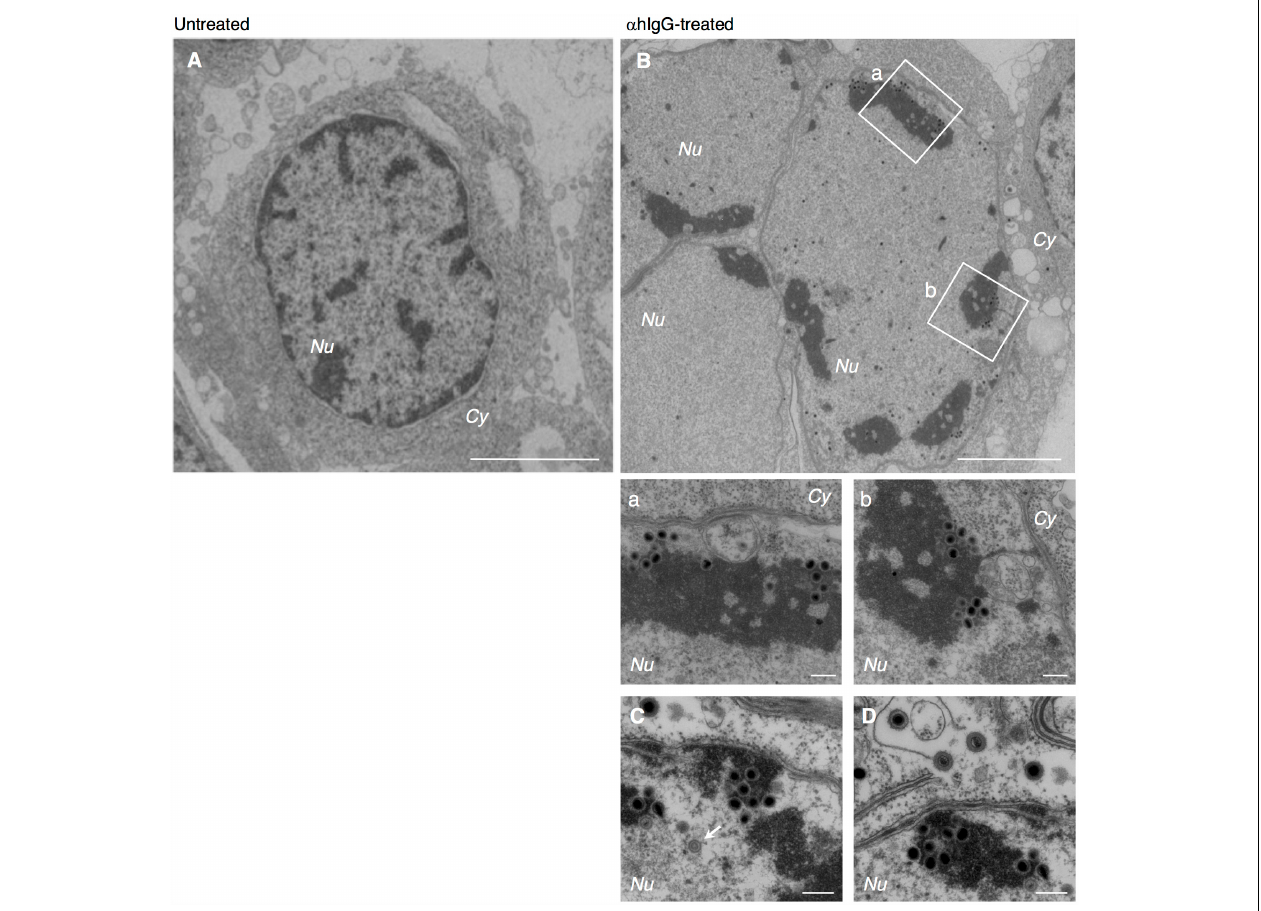
FIGURE 1 | Electron micrograph showing nucleocapsid formation in the nucleus of Akata cells induced into the lytic cycle of EBV. Morphological features of Burkitt’s lymphoma cells induced lytic infection of EBV. Akata − eGFP-EBV cells were treated without (A) or with (B) α hIgG for 24 h. Low (A,B) and high (a,b,C,D) power views of Akata − eGFP-EBV cells. (a) and (b) represent boxed areas in (B) . The white arrow indicates a double-layered capsid without core. Scale bars: 2.5 µ m (A,B) and 250 nm (a,b,C,D) . In all the electron micrographs, italic abbreviations used for describing cellular compartments are as follows; Cy, cytoplasm; Nu, nucleus; Ve, vesicles; Ex, extracellular space; PM, plasma membrane; INM, inner nuclear membrane; ONM, outer nuclear